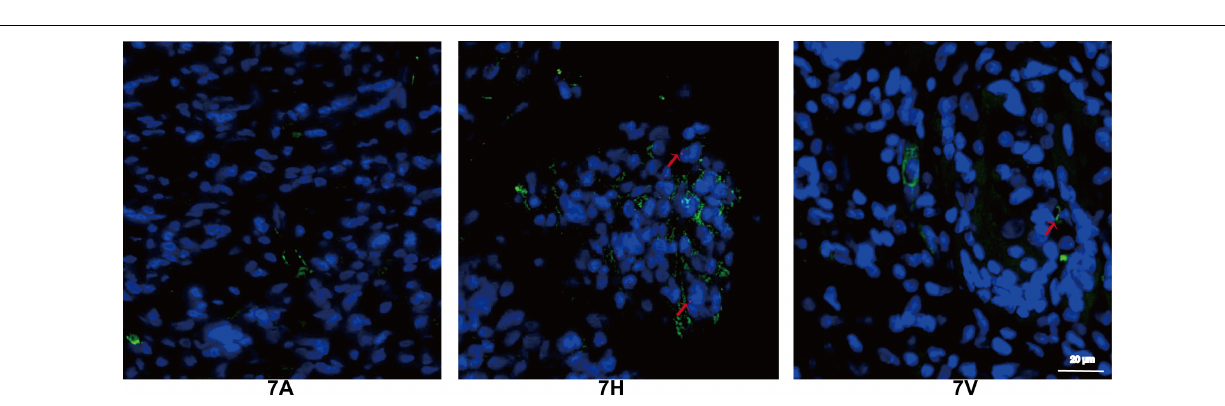
FIGURE 9 | Tracking of ADSCs in regenerative tissue by FISH at 12 weeks (green: CD34, orange: Y chromosome, blue: DAPI). Red arrows indicate endothelial cells differentiated from ADSCs (Scale bar = 20 µ